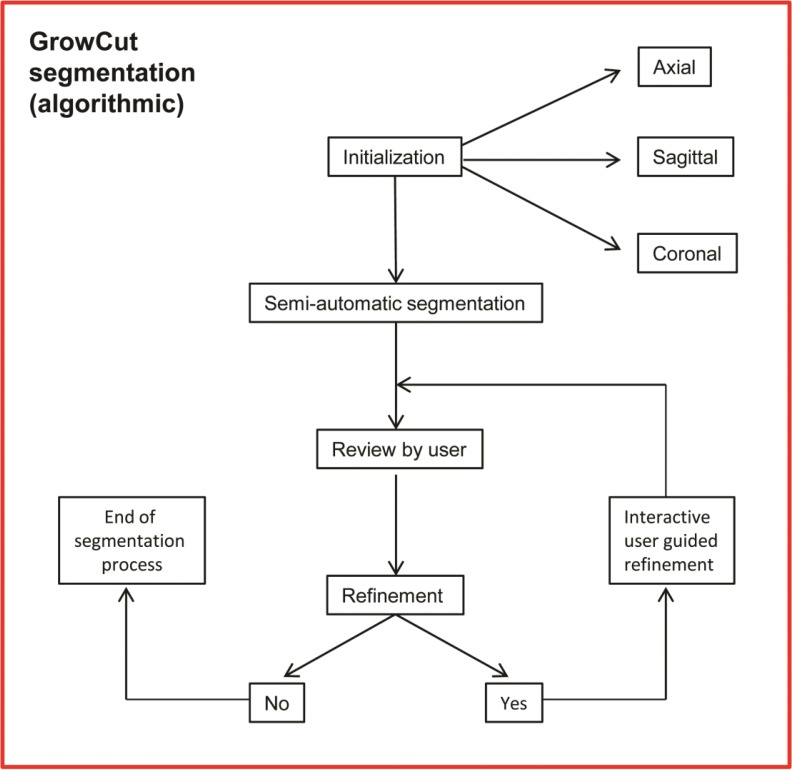
Workflow: The phases of the user guided GrowCut segmentation process is shown separately in more detail.Note: The used segmentation procedures were performed equally for each data set.